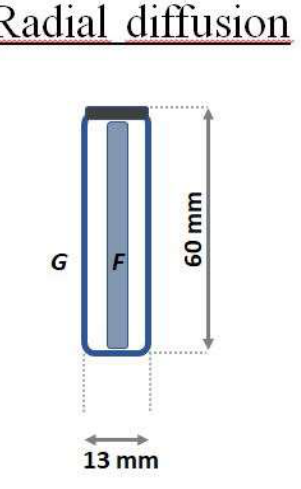
Figure 2. Schematic representation of a radial sampler. Adsorbent nanostructured material (F), the diffusive body (G).